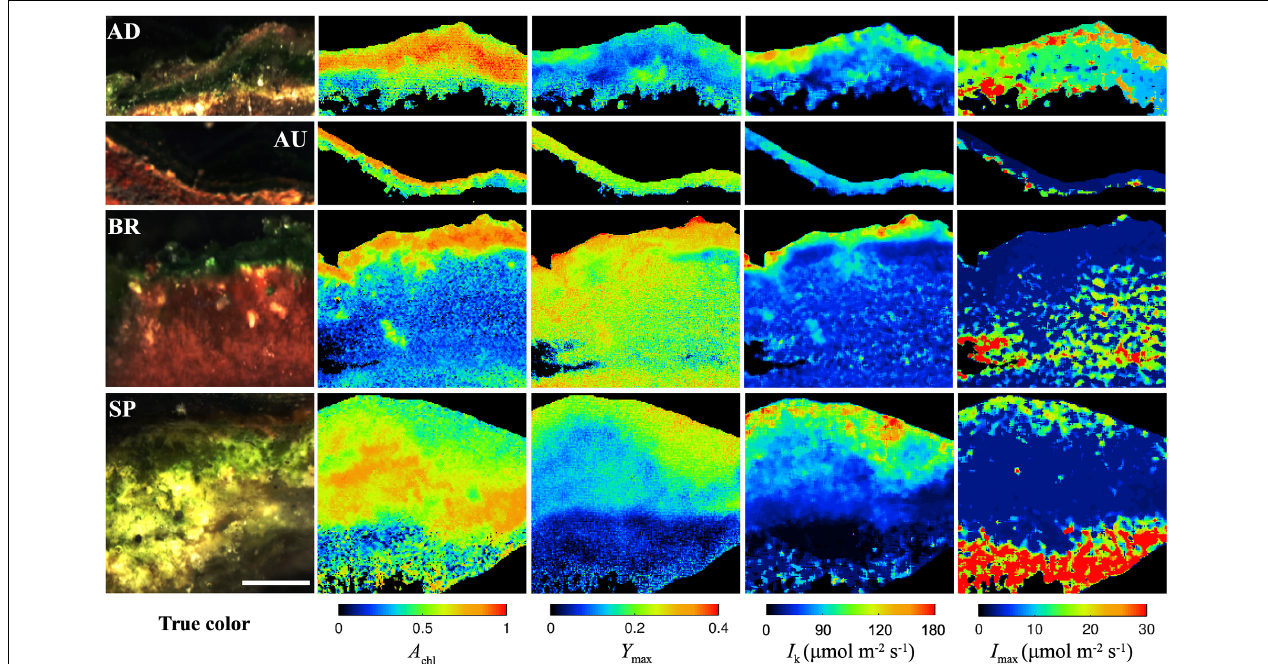
FIGURE 2 | Example images of the AD, AU, BR, and SP mats obtained by hyperspectral imaging (column “true color”), reflectance imaging ( A chl ), and PAM imaging ( Y max , I k , I max ). Scale bar is 1mm.